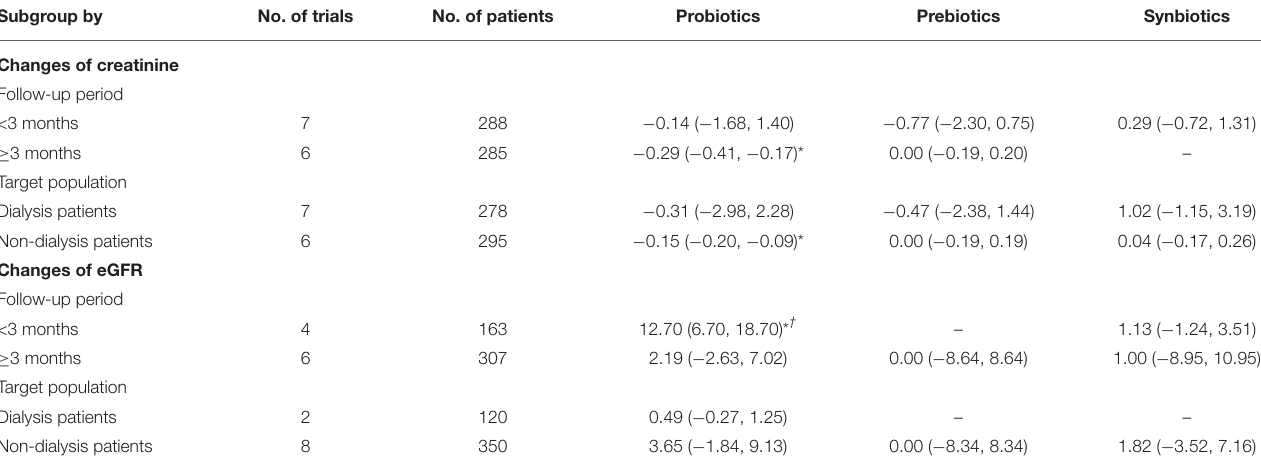
TABLE 2 | Subgroup analysis of renal function.